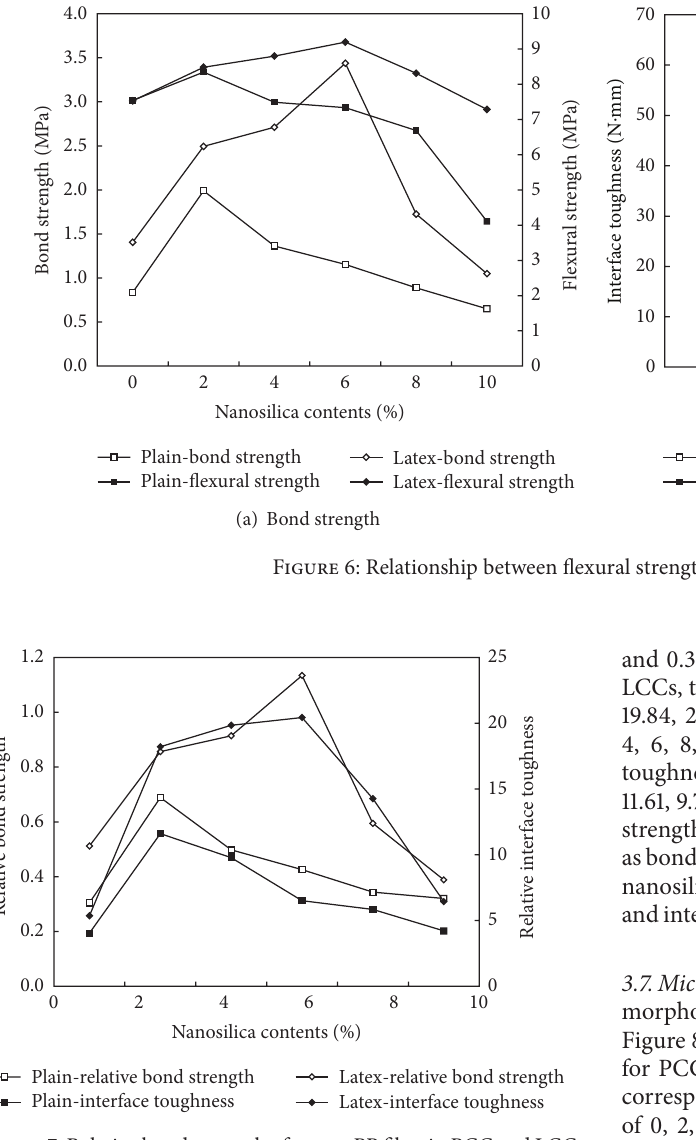
Figure 7: Relative bond strength of macro PP fiber in PCC and LCC with nanosilica